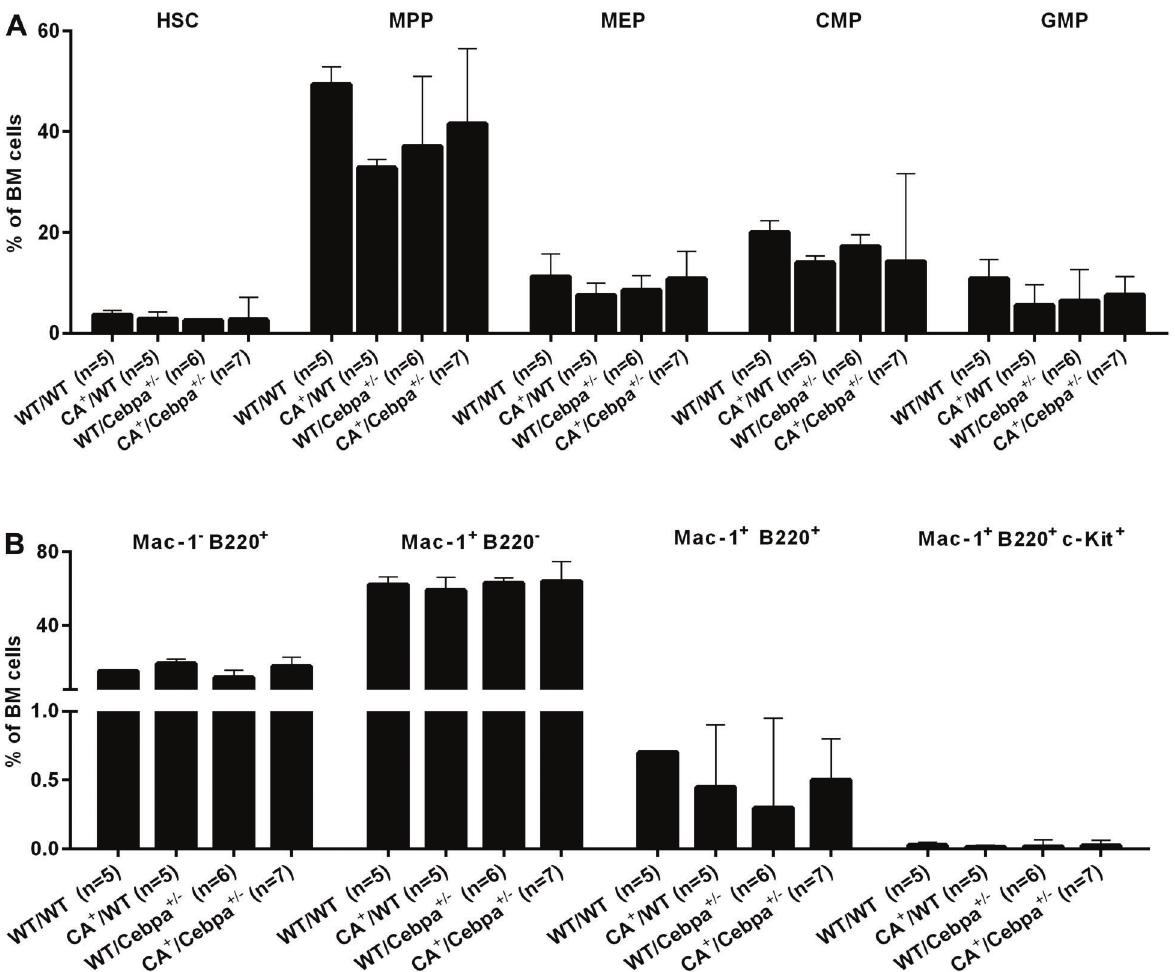
Figure 2. Immunophenotypic characterization of bone marrow (BM) hematopoietic progenitor cells between mice groups. WT/WT : wild- type (control); CA + / WT : CALM/AF10 ; WT/Cebpa + / – : Cebpa + / – ; CA + / Cebpa + / – : double-mutant mice. A , Frequencies of HSC (hematopoietic stem cells, Lin - Sca1 + c-Kit + ), MP (myeloid progenitor cells, Lin - Sca1 - c-Kit + ), MEP (megakaryocyte-erythrocyte progenitor cells, Lin - Sca - c-Kit + Fc lo CD34 - ), CMP (common myeloid progenitor cells, Lin – Sca – c-Kit + Fc lo CD34 + ), and GMP (granulocyte-macrophage progenitor cells, Lin – Sca – c-Kit + Fc hi CD34 + ) of WT/WT , CA + / WT , WT/Cebpa + / – , and CA + / Cebpa + /